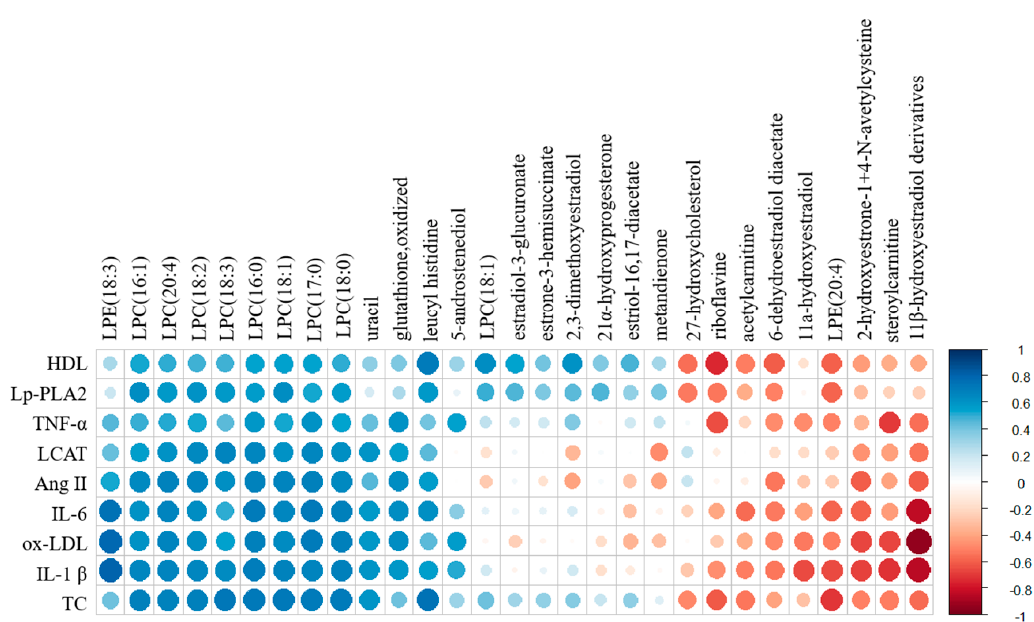
Figure 3. Analysis of correlations between identified metabolites and steroid hormones and blood health-related factors. The correlation matrix was analyzed and visualized with a heat map generated with the R corrplot package. Positive correlations are shown in blue, and negative correlations are shown in red.